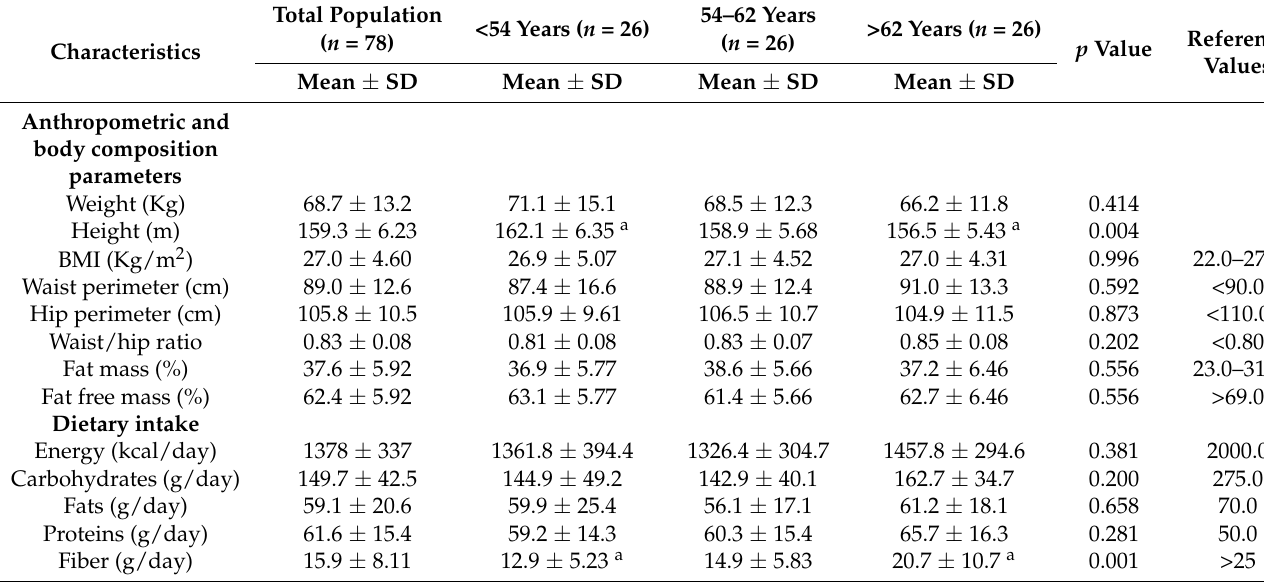
Table 1. Anthropometric, body composition, dietary, and sociodemographic variables by